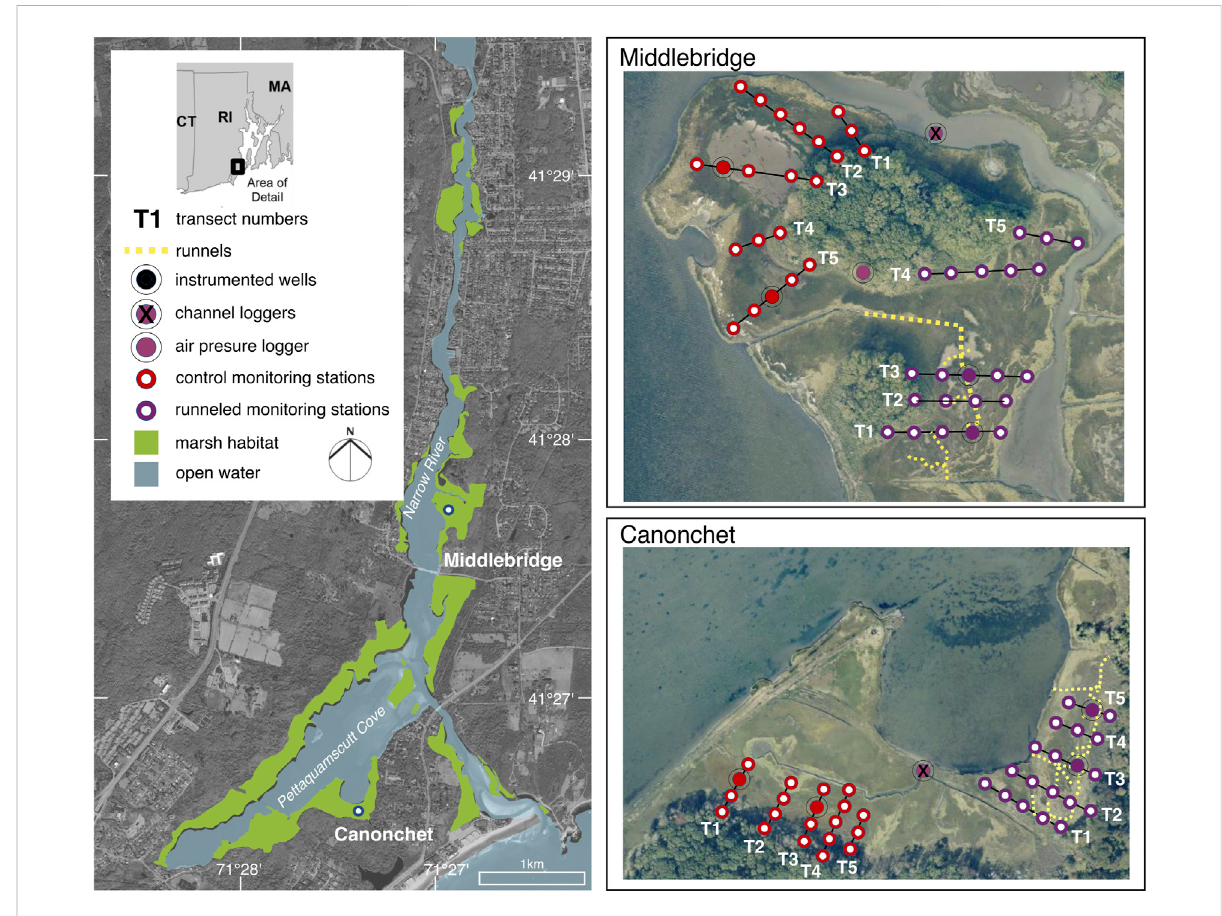
FIGURE 3 Location map showing the Narrow River Estuary, including runneled and control areas at Middlebridge and Canonchet. Vegetation monitoring transects aredepicted as T1 – T5.Red areasare control areas, purple arerunneled areas. Groundwater wellsmonitored(focal wells) are depictedbya circle with a solid fi ll.